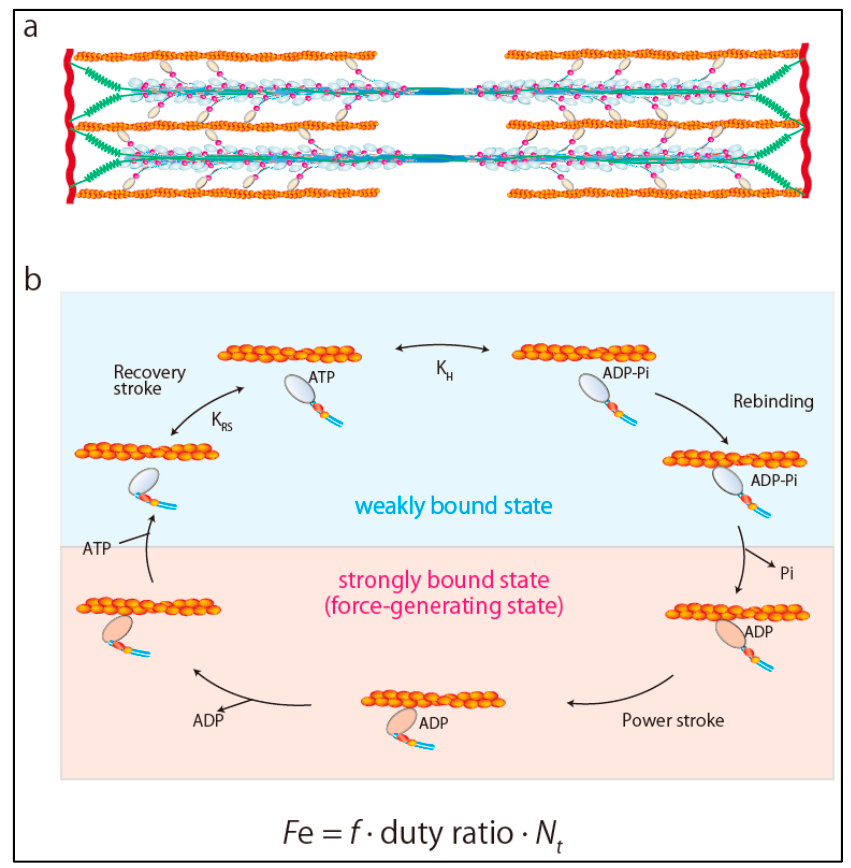
Figure 1. Ensemble force of sarcomere. ( a ) Structure of sarcomere. ( b ) Chemomechanical cycle of actomyosin. Ensemble force is determined as Fe = f × duty ratio × N t .